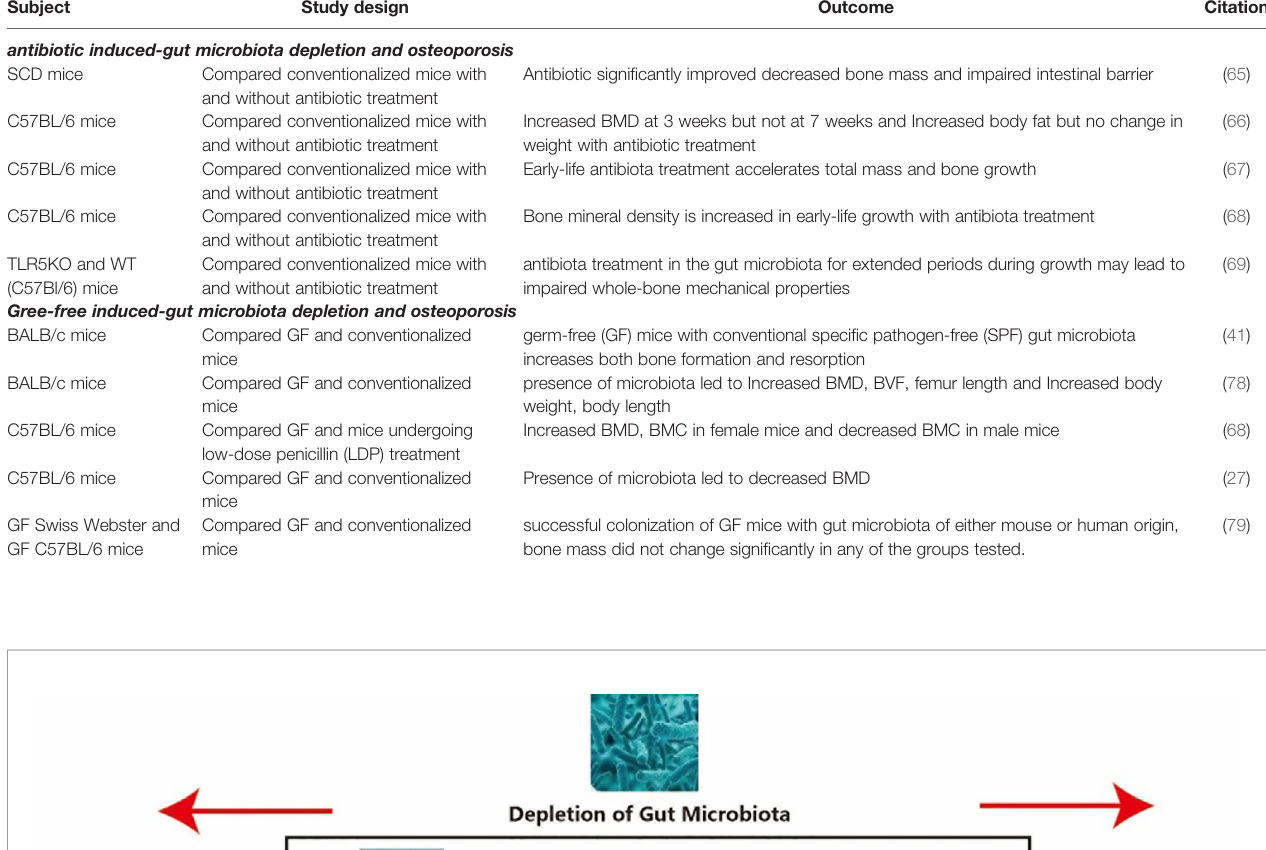
TABLE 1 | Gut microbiota depletion studies on osteoporosis.